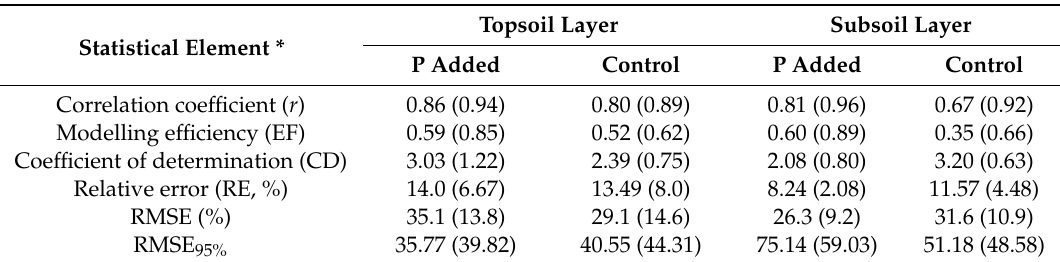
Figure 1. Comparison of soil water contents in the top ( A : 0–23 cm) and the subsoil ( B : 23–46 cm) between simulation and observation (three replications) covering two growing seasons for both Control and P added treatments. The error bars represent the standard deviation. Table 1. Model performance statistics on comparison between simulated and observed soil moisture in top (0–23 cm) and sub (23–46 cm) soil layers ( n = 15) (numbers in parenthesis are the result excluding the unusual sample dated on 25 February